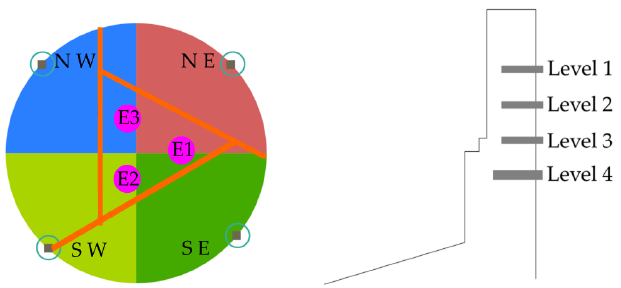
Figure 7. ( Left ) radial location of the 4 panels to evaluate and ( Right ) detail side view of each panel with its 4 levels of plate coolers. Sixteen thermocouples in total were used as output